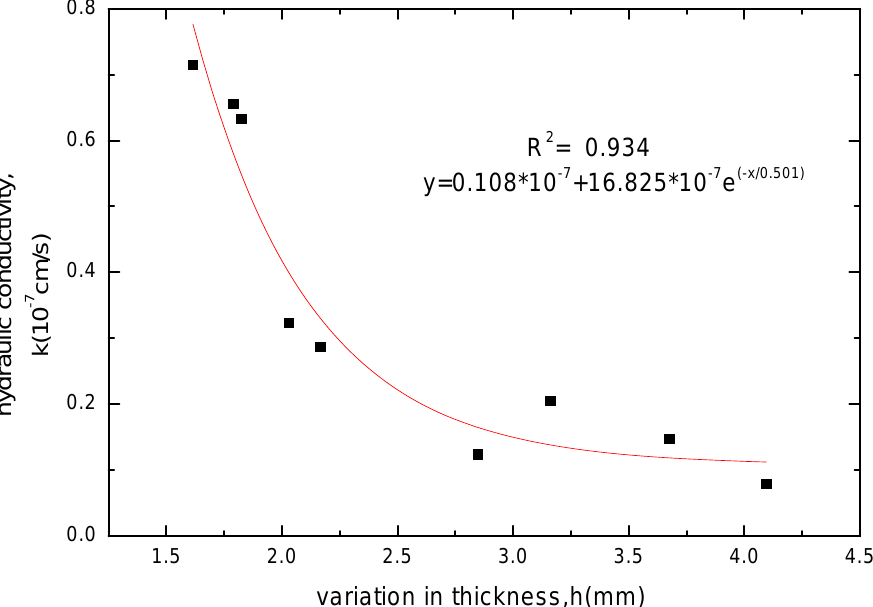
Figure 11. The relationship between hydraulic conductivity and thickness increase for GCL specimens soaked with KCl